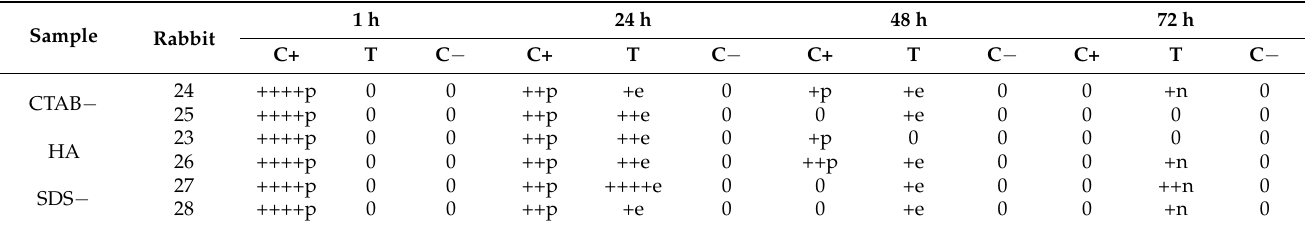
Table 2. Inoculation parameters after the positive control administration.